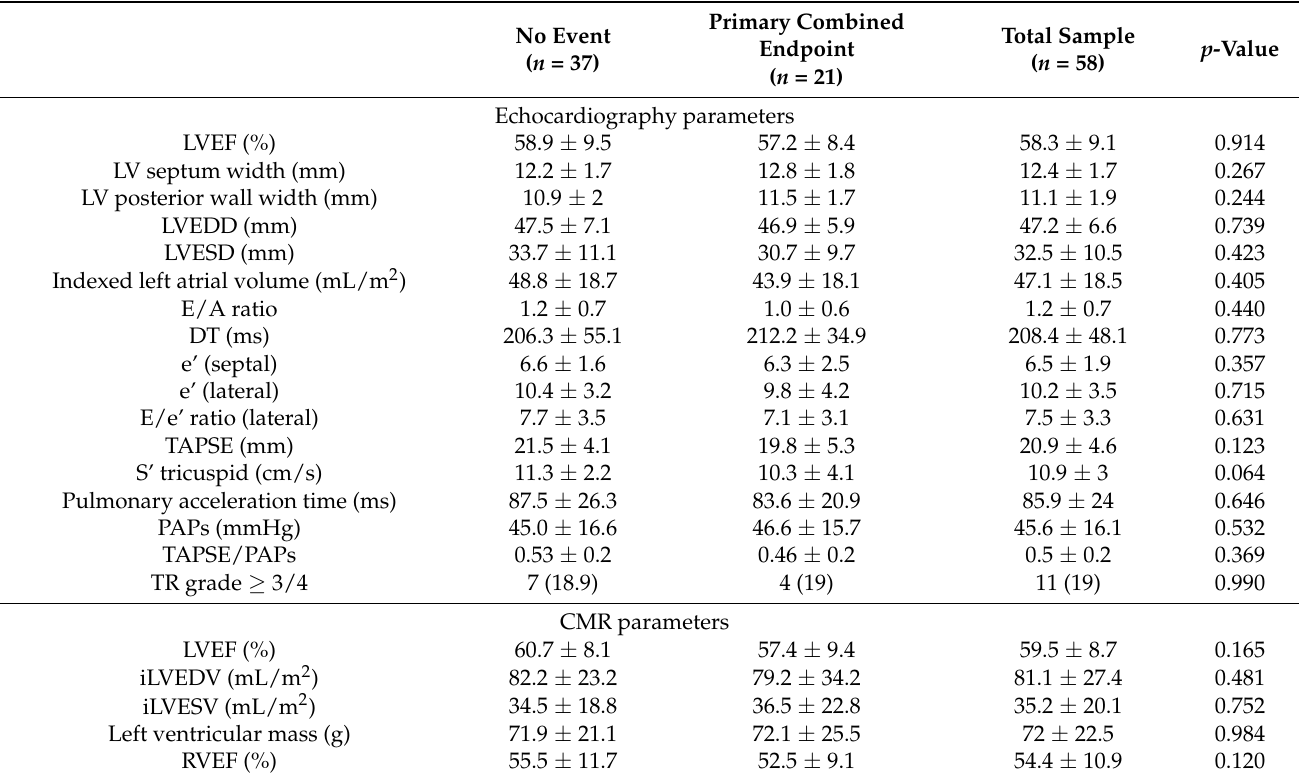
Table 2. Baseline imaging and hemodynamic parameters according to the primary combined end-